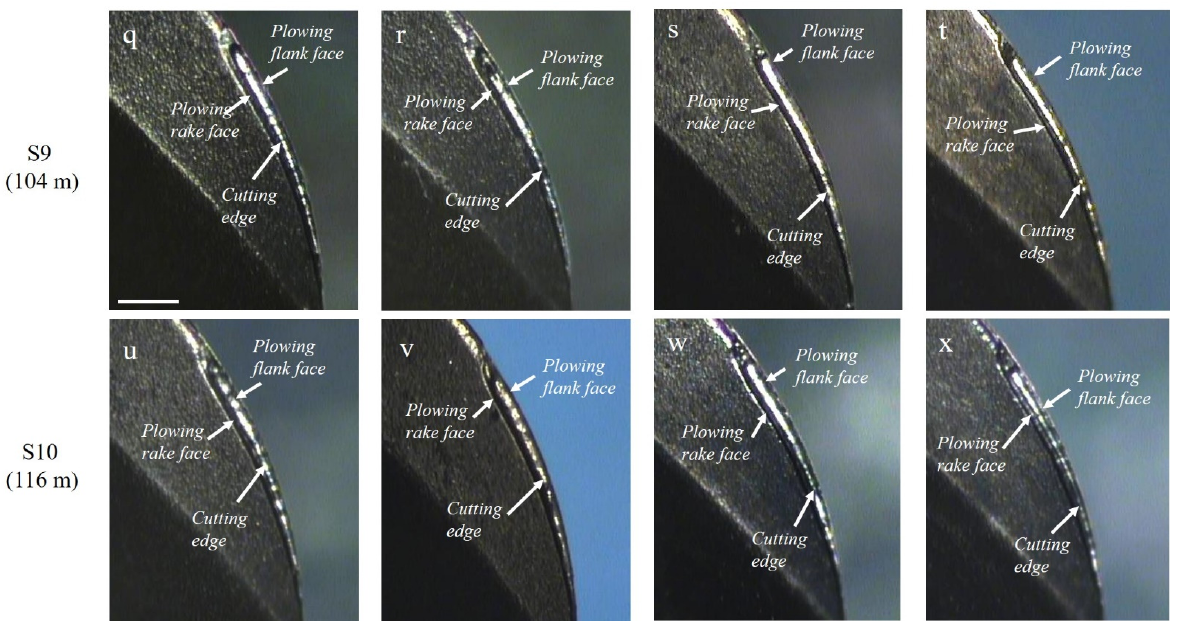
Figure 9. Side view of tool wear for MCD and NCD-coated tools during high-speed milling at steps ( a – d ) 1, ( e – h ) 4, ( i – l ) 5, ( m – p ) 7, ( q – t ) 9, and ( u – x )